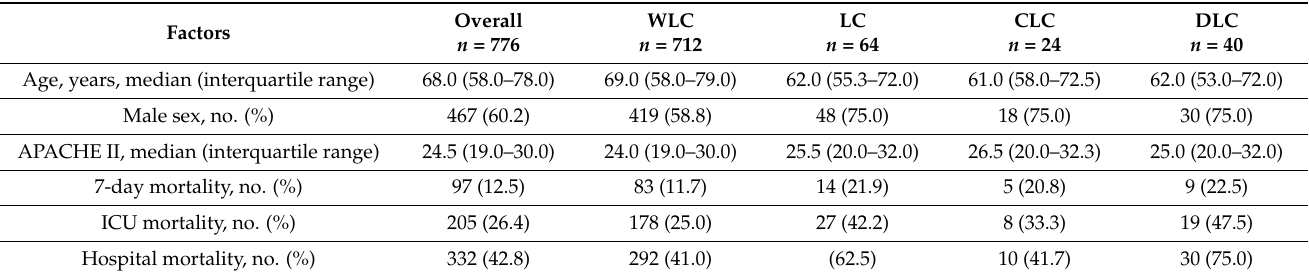
Table 1. Patient characteristics ( n = 776 patients).